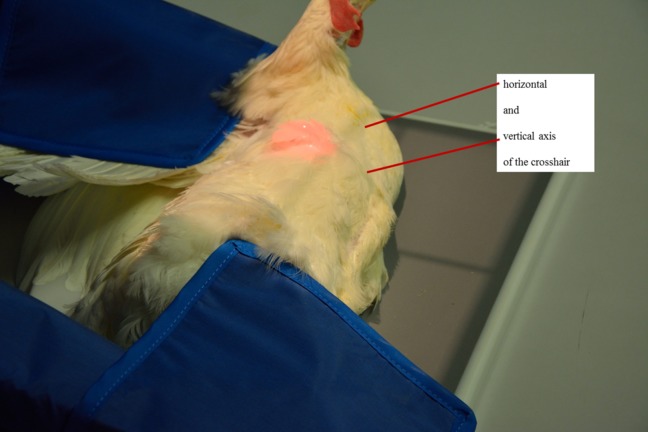
Positioning of the animal on the X-ray detector.The red lighted area indicates the radiation field center.